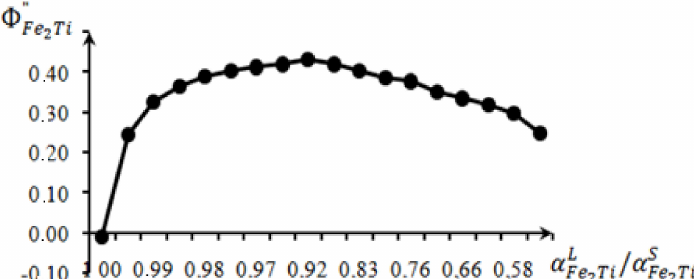
Figure 2. The dependence of the Bjerrum–Guggenheim